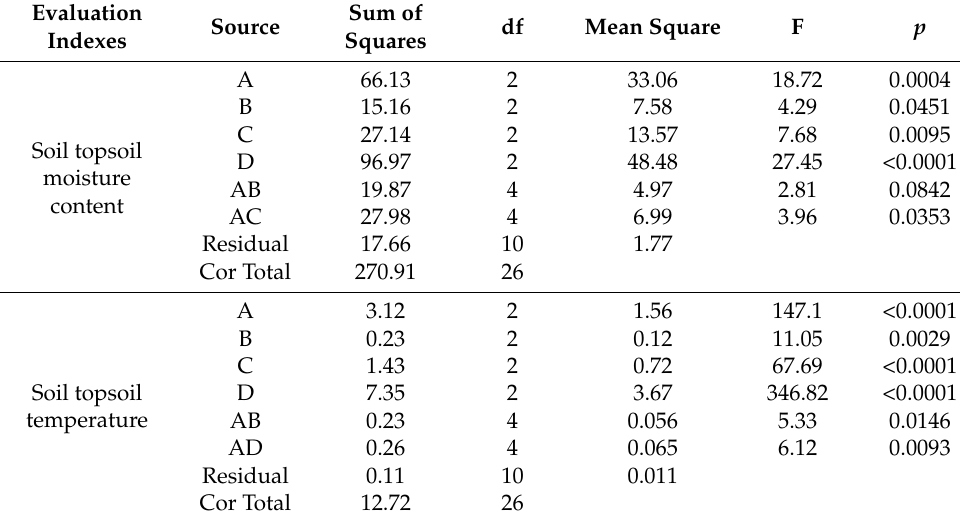
Table 3. Table of analysis of variance of test results for the influence of corn straw morphological combinations on soil temperature and moisture.